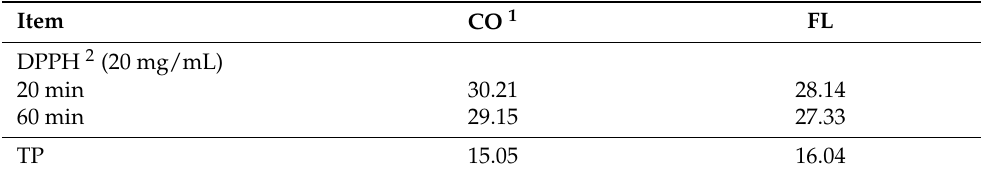
Table 2. Feed DPPH and total phenolic